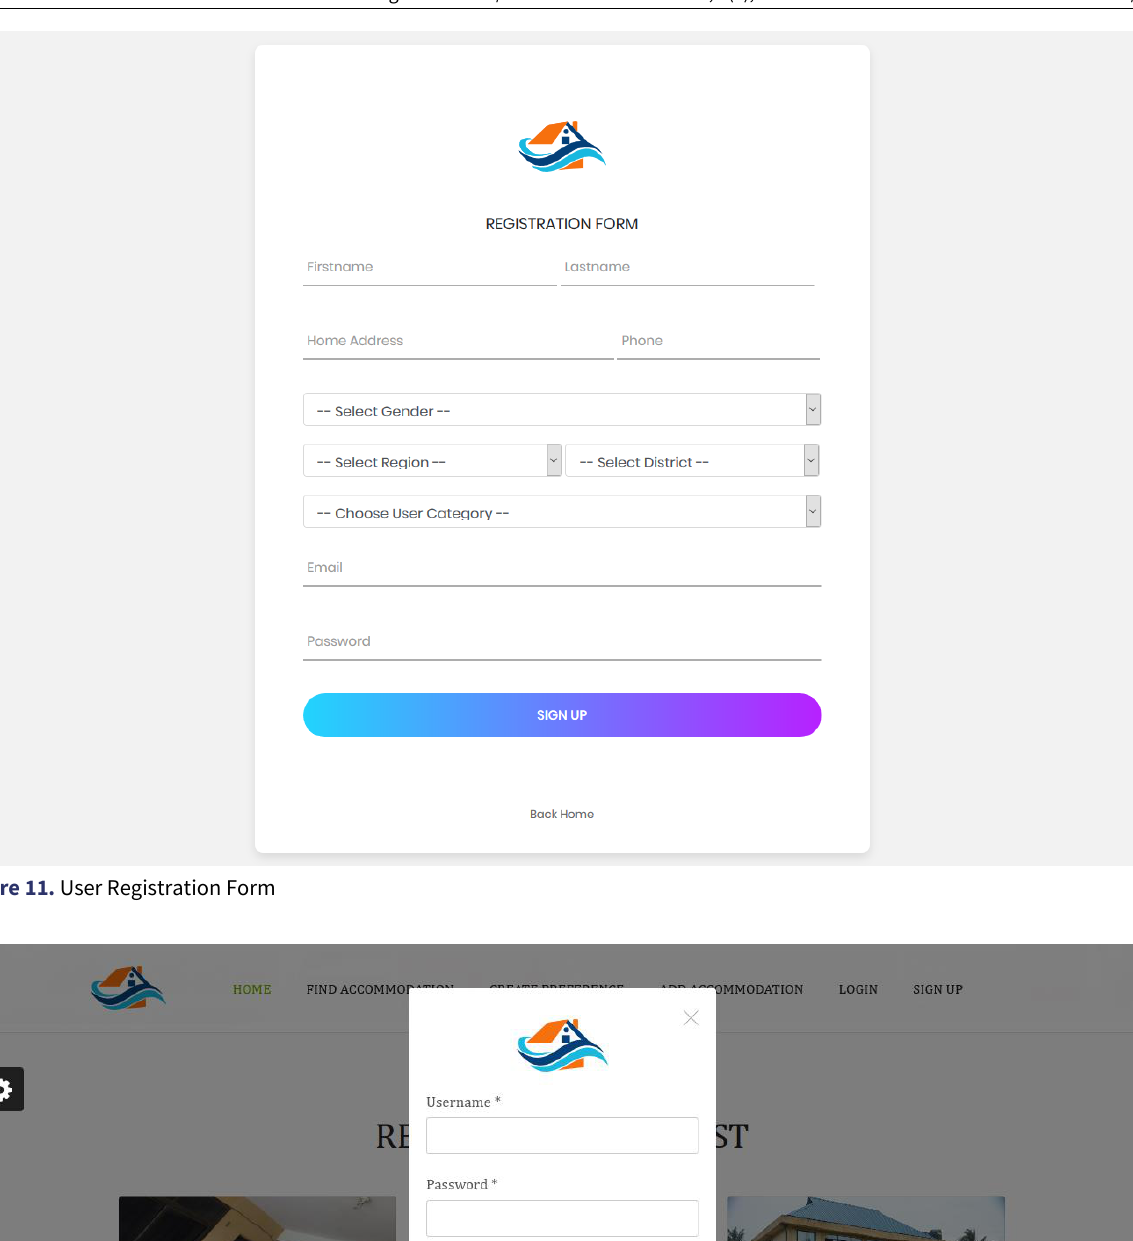
Figure 12. Login Form for Registered